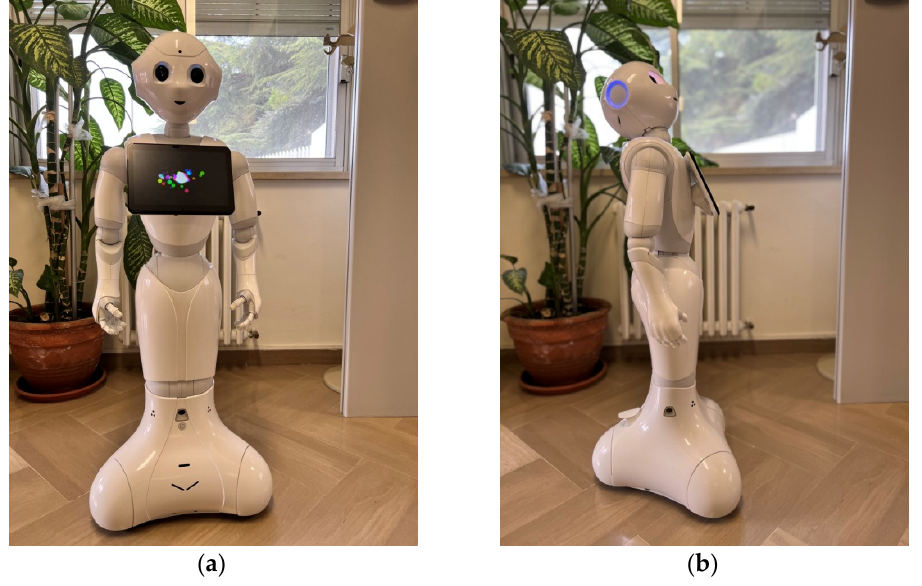
Figure 1. Overview of Pepper robot in front view ( a ) and side view ( b